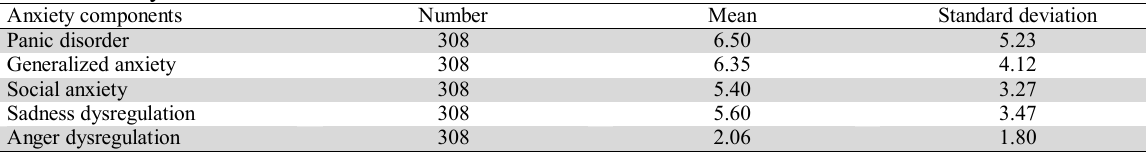
The summary of some basic